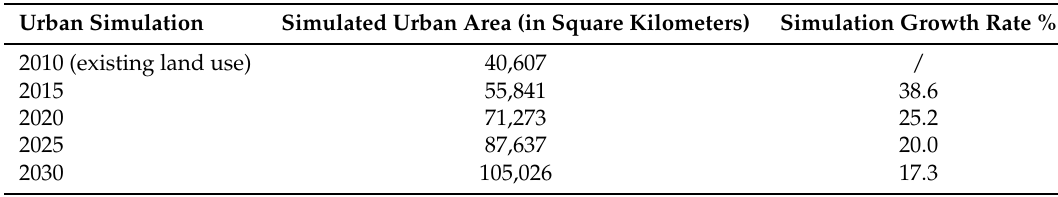
Table 6. Simulated urban growth until